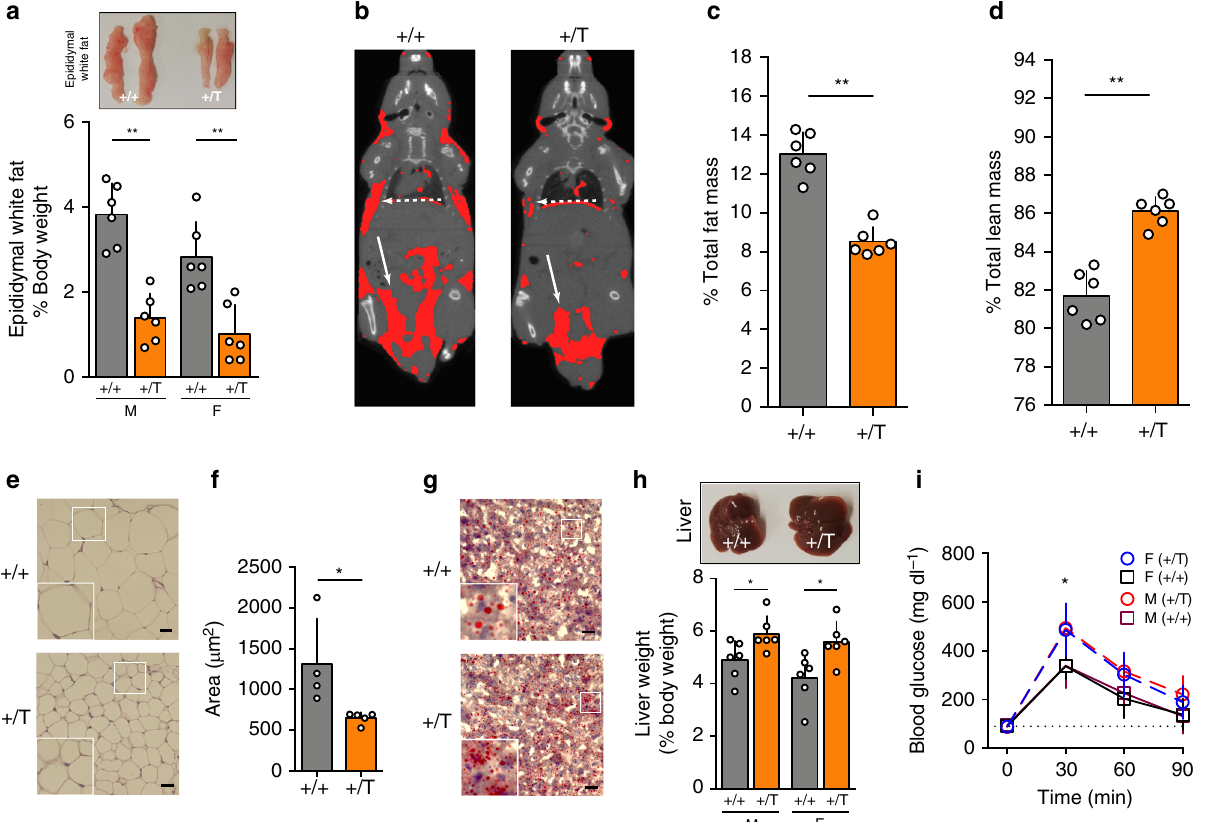
Fig. 2 GH/IGF-1 hypersecretion leads to alterations in Ghrhr Gpr101 mice body composition. a Picture: Epididymal white fat from WT ( + / + ) and Ghrhr Gpr101 ( + /T). Bars: quanti fi cation of epididymal white fat weight normalized to total body weight ( n = 6 mice/group, p = 0.0022 for males and females). b Representative CT images segmented for fat of 27-week-old WT ( + / + ) and Ghrhr Gpr101 ( + /T) mice ( n = 6 mice per group). Total volume is in grayscale and fat volume is in red. Plain white arrows indicate subcutaneous fat and dashed arrows epididymal fat distribution. c Percentage of fat mass in WT ( + / + ) and Ghrhr Gpr101 ( + /T) mice ( n = 6 mice per group, p = 0.0022) determined by CT-scan analysis. d Percentage of lean mass in WT ( + / + ) and Ghrhr Gpr101 ( + /T) mice ( n = 6 mice per group, p = 0.0022) determined by CT-scan analysis. e 27-week-old WT ( + / + ) and Ghrhr Gpr101 ( +